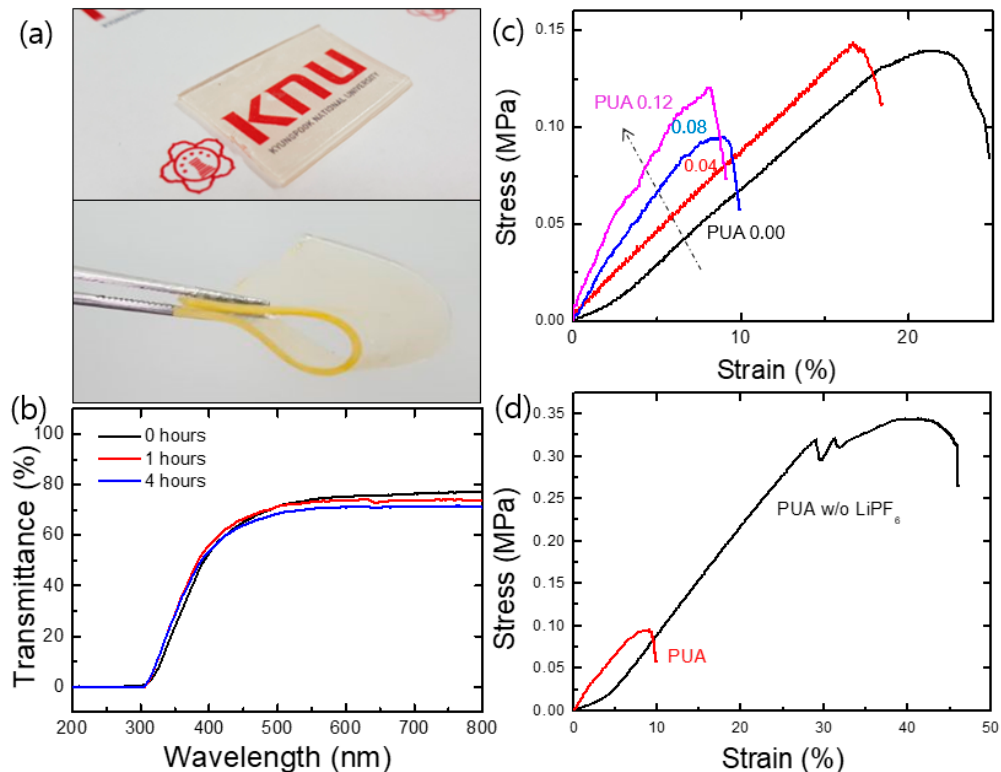
Figure 3. Digital images of the self-standing PUA membranes (thickness: 2.0 mm) showing their ( a ) optical transparency and flexibility and their ( b ) UV–Vis transmittance depending on swelling time.